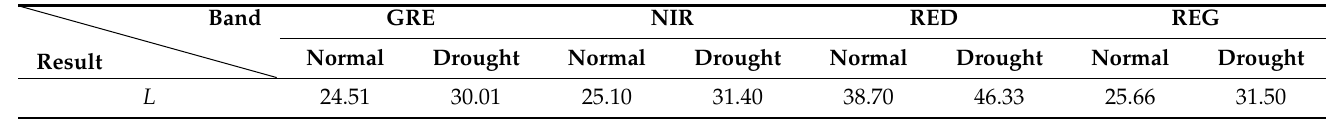
Table 8. Wilting index of the soybean canopy multispectral image in the V4 stage.